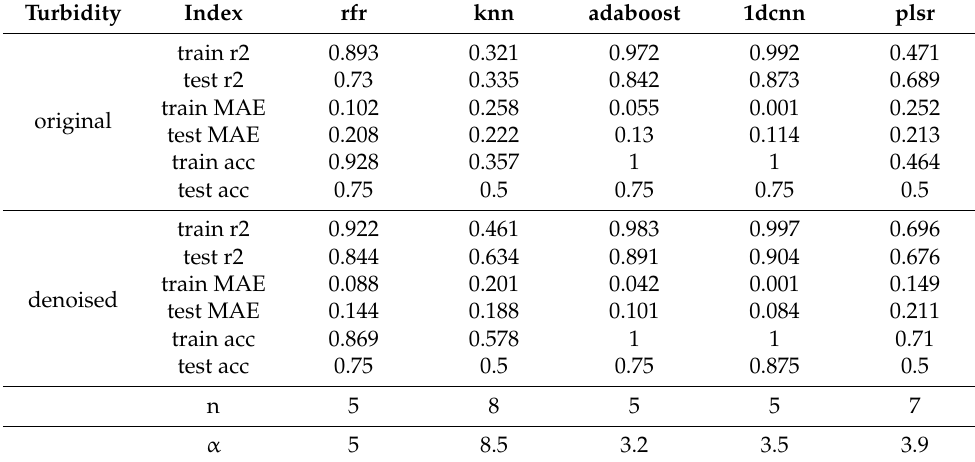
Table 4. The accuracy results of retrieving